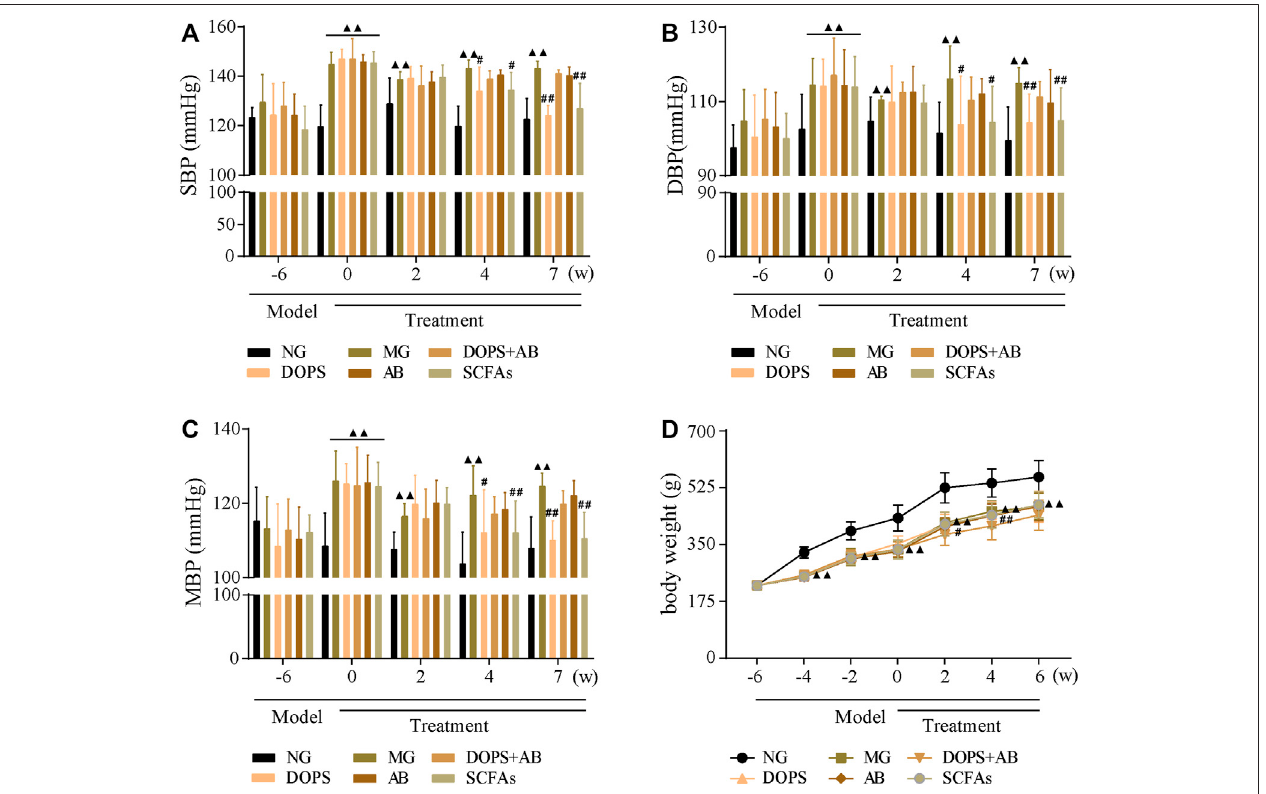
FIGURE 2 | Effect of DOPS on blood pressure in the MH rats. (A) Changes in systolic blood pressure (SBP). (B) Changes in diastolic blood pressure (DBP). (C) Changes in mean arterial pressure (MBP). (D) Changes in bodyweight. NG, normal control group; MG, model control group; DOPS, Dendrobium of fi cinale polysaccharide; DOPS + AB, Dendrobium of fi cinale polysaccharide + antibiotics; AB, antibiotics; SCFAs, short-chain fatty acids. Compared with the normal control group, ▲ p < 0.05 and ▲▲ p < 0.01; compared with the model control group, # p < 0.05 and ## p < 0.01 ( n =